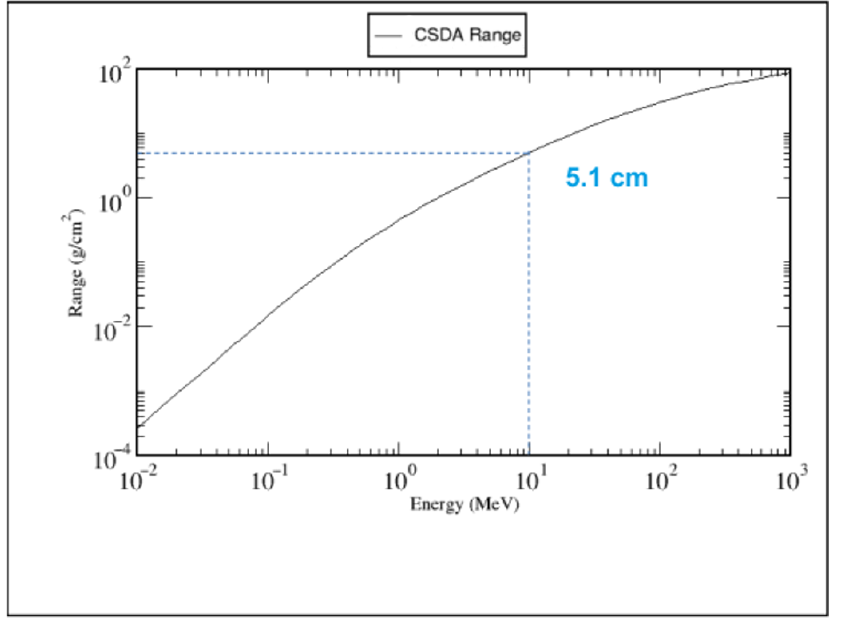
Figure A1. Simulation results depicting the range of electron beams with ~90 eV mean excitation energy in PDMS:TEOS:TPOZ with 67:13:20 m% proportions.